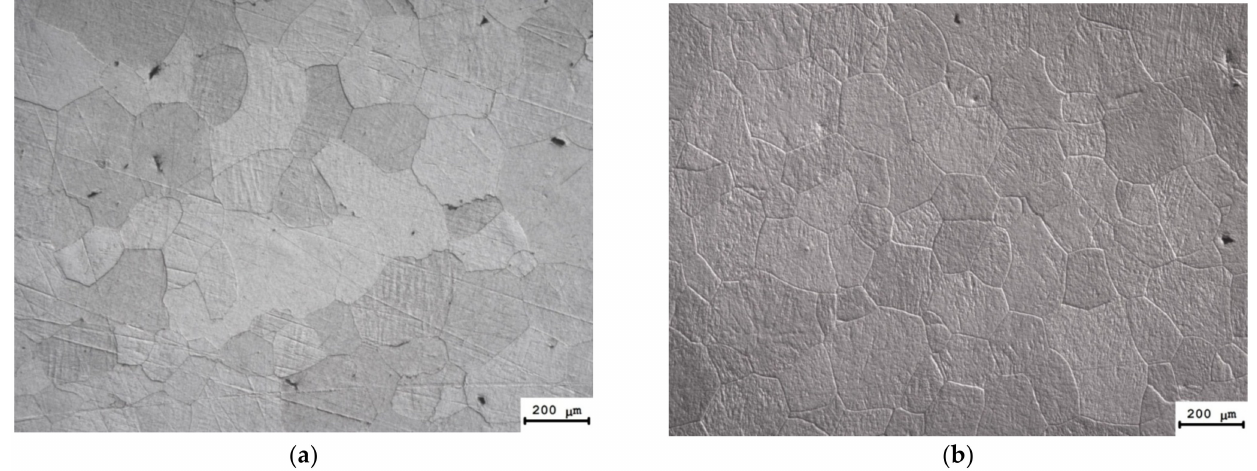
Figure 3. The microstructure of alloys after ECAP and annealing at 400 ◦ C for 2 h: ( a ) Alloy #3; ( b ) Alloy #4.